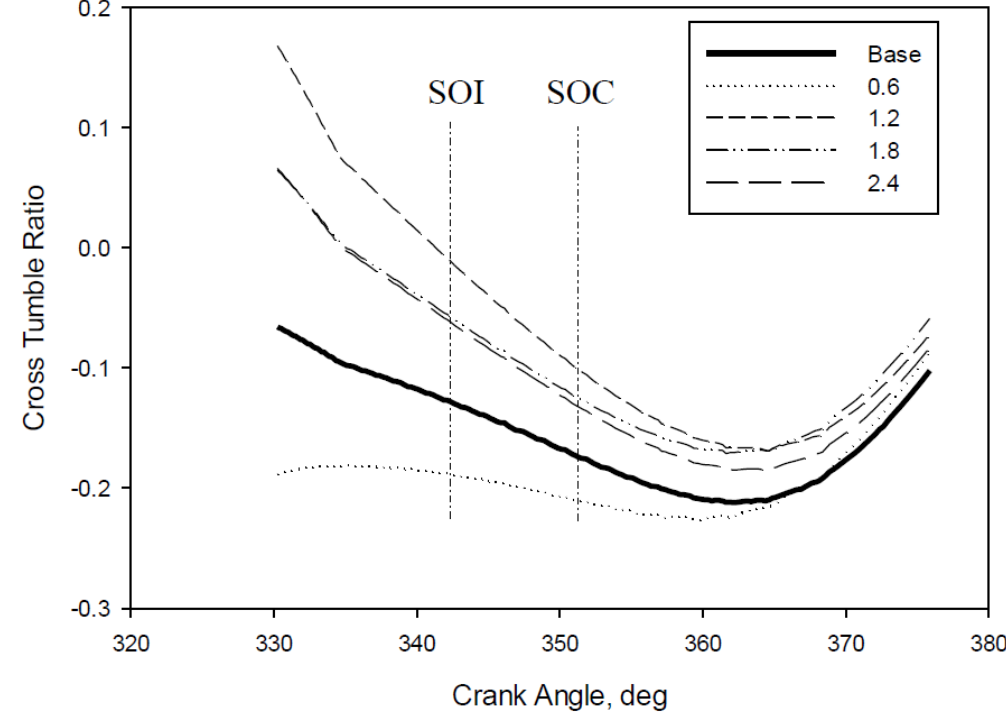
Figure 11. The plot of the cross tumble ratio against the crank angle.